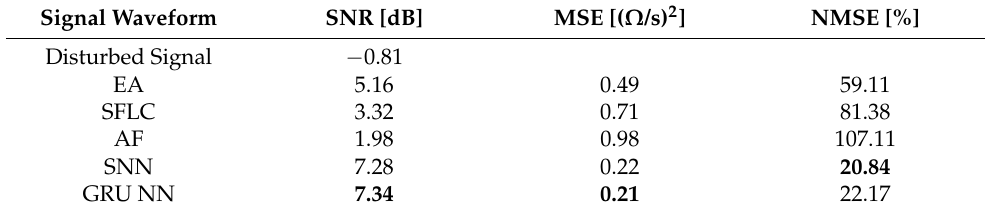
Table 3. ICG signal waveform performance metrics for force